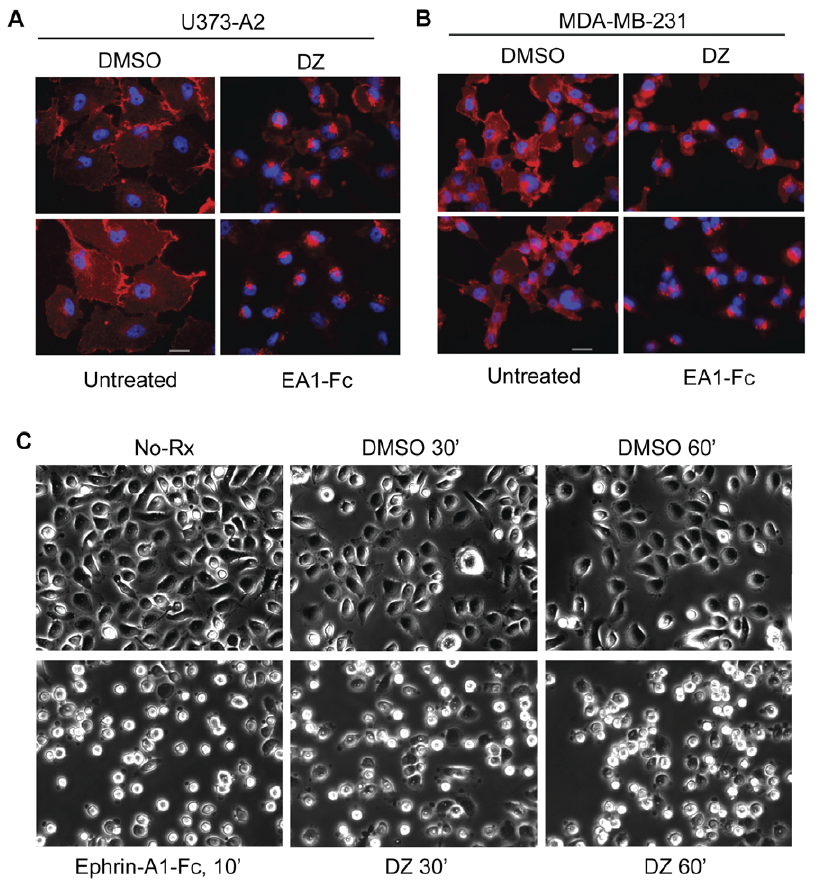
Figure 5. Doxazosin treatment causes EphA2 receptor internalization and induces cell rounding. (A) Immunofluorescence staining of U373-A2 cells for EphA2 receptor (red) after treatment for 60 minutes with 50 m M DZ in 0.2% DMSO. Treatment with 1 m g/ml ephrin-A1-Fc and DMSO served as positive and negative controls, respectively. DAPI nuclear staining is shown in blue. (B) Immunofluorescence staining of MDA-MB-231 cells for EphA2 receptor (red) after treatment for 120 minutes with 50 m M DZ in 0.2% DMSO. Controls are as given above. Scale bars, 25 m m. (C) Images from cell rounding analysis of PC-3 cells stimulated with 50 m M doxazosin for 30 or 60 min. Stimulation with 2 m g/ml ephrin-A1-Fc for 10 min or 0.2% DMSO served as positive and negative controls, respectively. Cells were seeded on 6-well plates and stimulated after 24 hours.